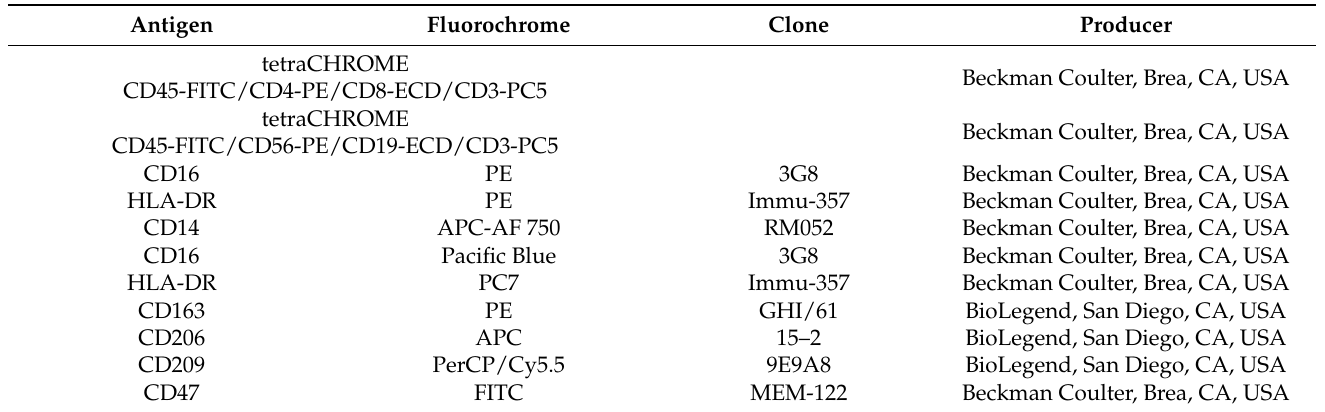
Table 1. Summary of monoclonal antibodies used for